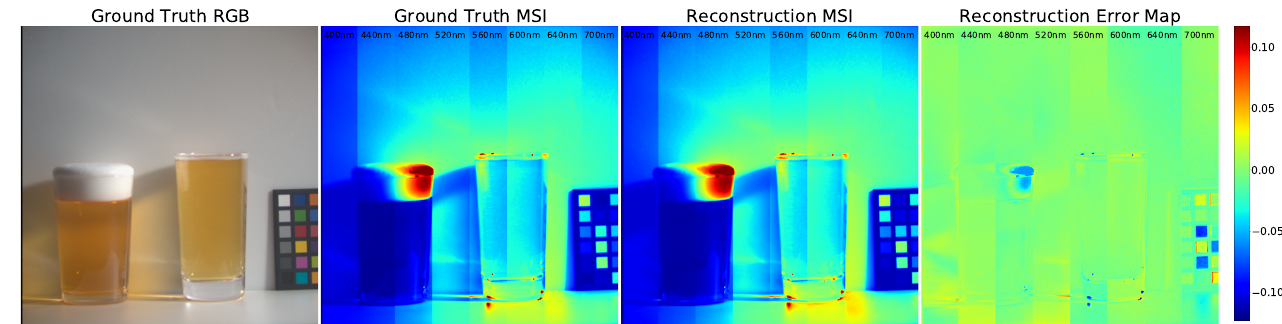
Figure 1. An example of reconstructing a multispectral image from an RGB